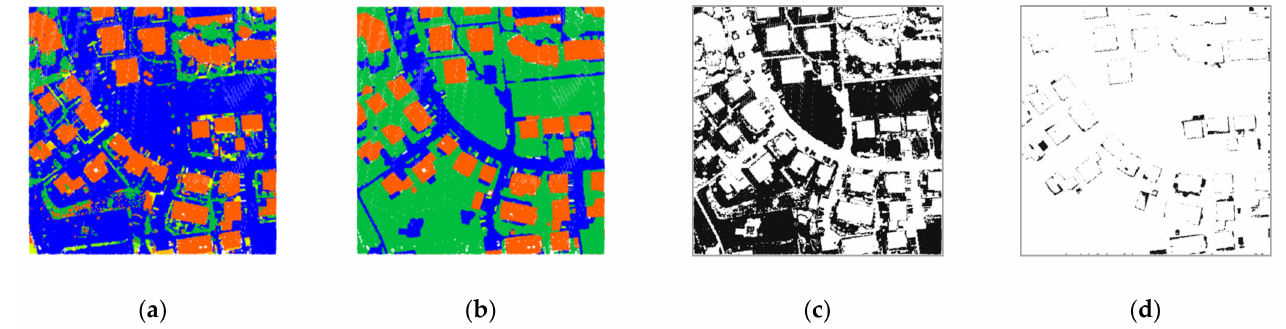
Figure 25. Results of semantic segmentation of new data 2 for Case 1: ( a ) prediction; ( b ) ground truth (i.e., label data); ( c ) difference between prediction and ground truth for all classes; ( d ) difference between prediction and ground truth for building class only.